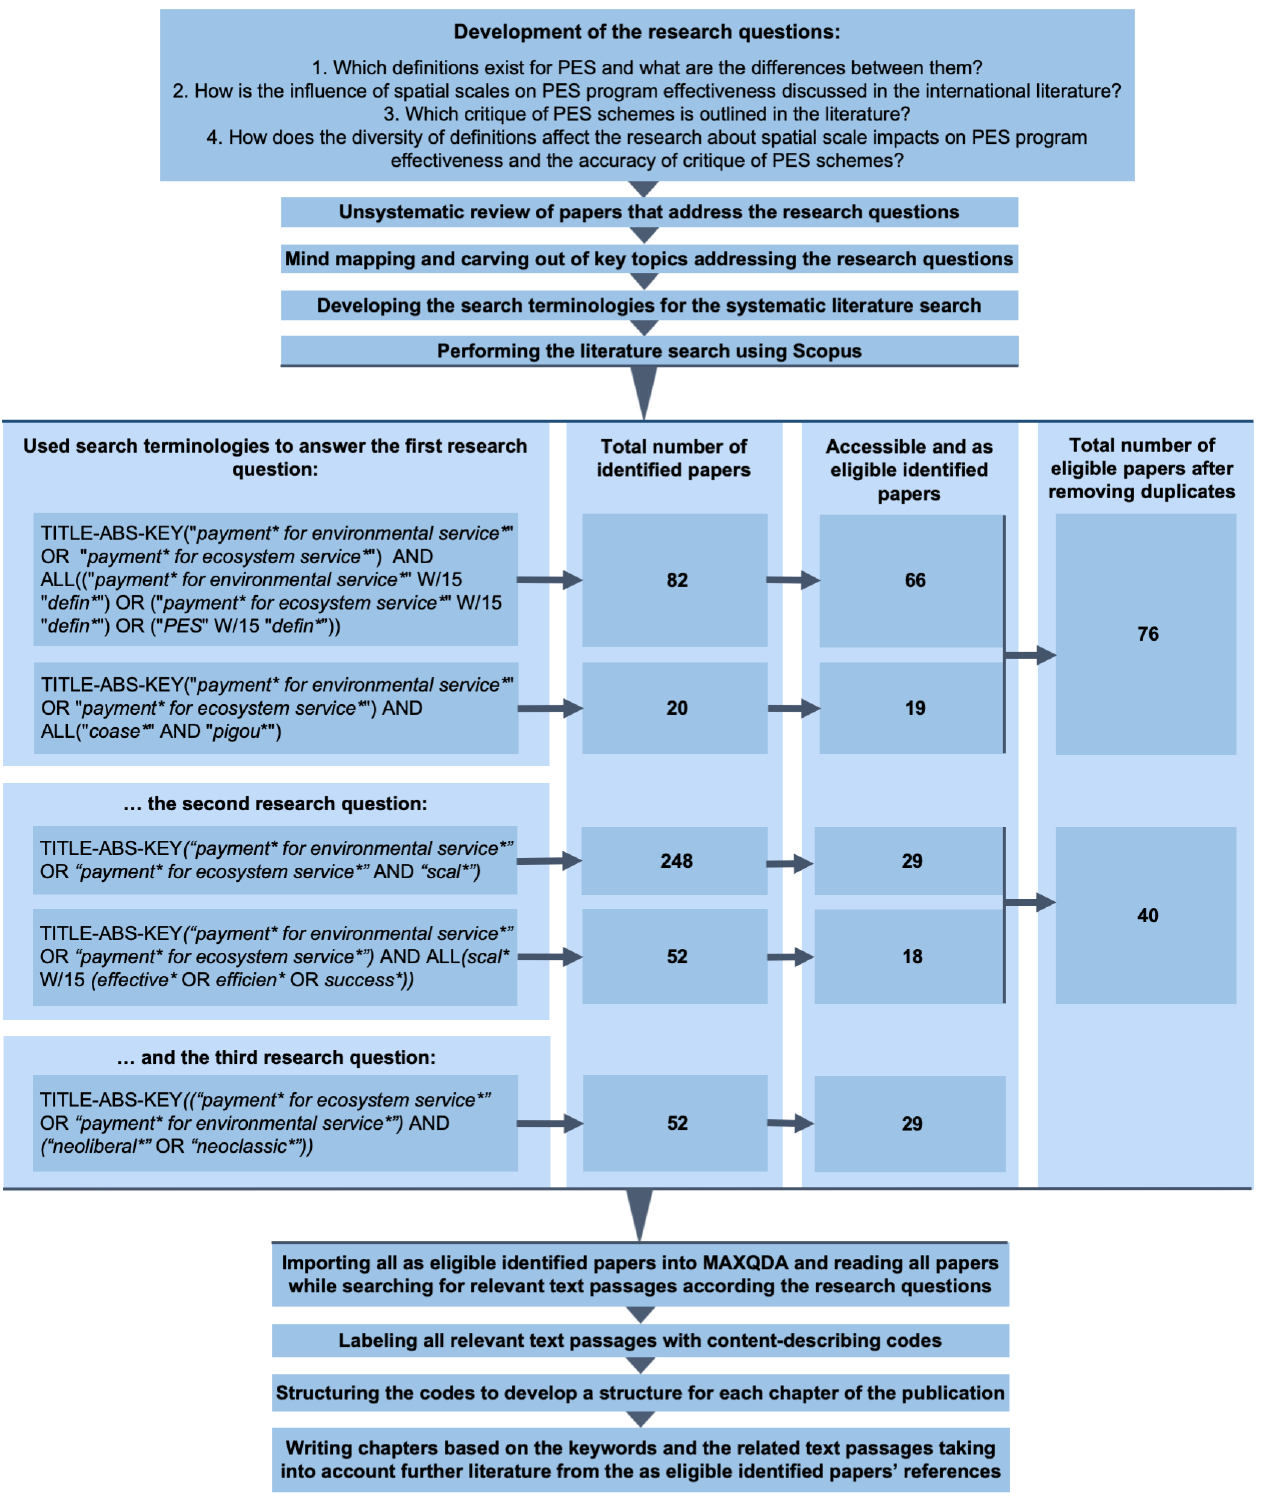
Fig. 1 . Methodological steps of this study and quantitative results of the literature